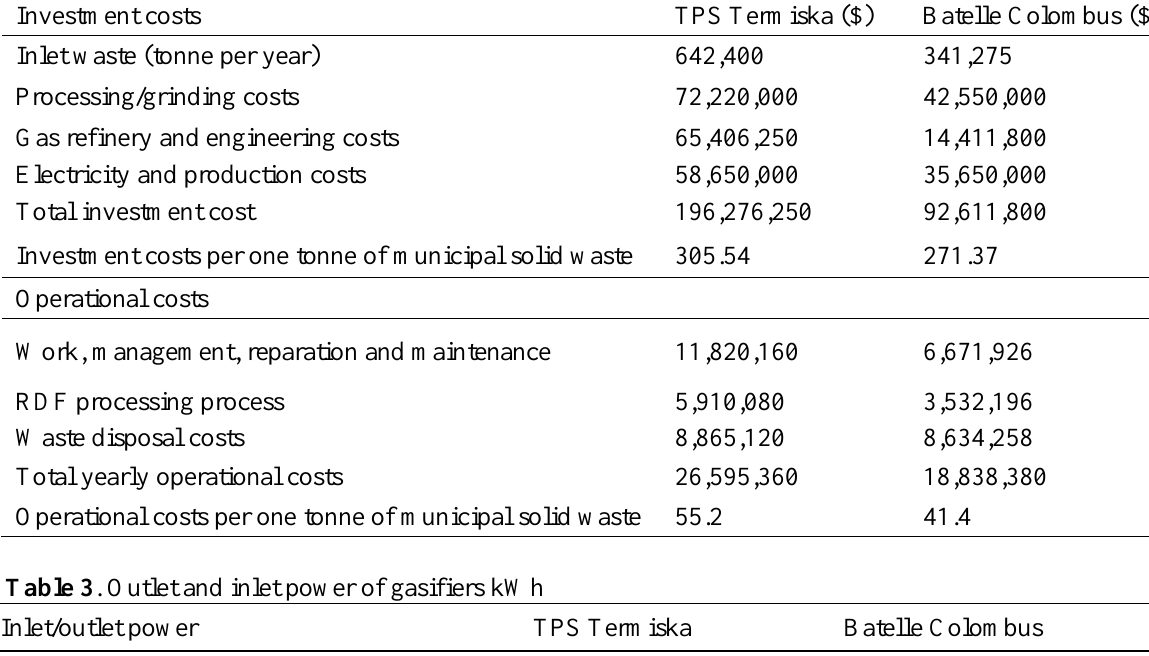
Table 2 . Precise analysis of investment and operational costs per one tonne of municipal solid waste the mentioned cost data are based on Klein’s studies in (2002)